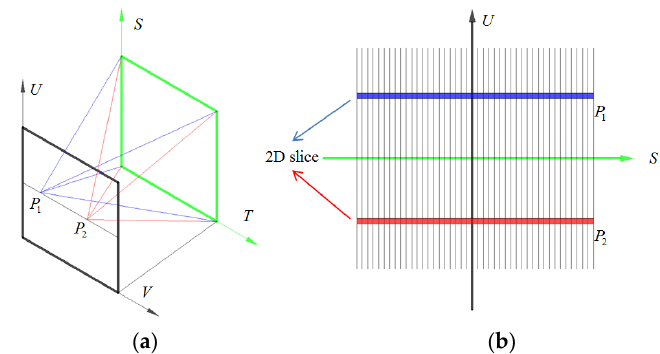
Figure 2. Two ‐ plane parametrization of light field. ( a ) Two ‐ plane parametrization; ( b ) two ‐ dimensional (2D) Cartesian ray ‐ space diagram.